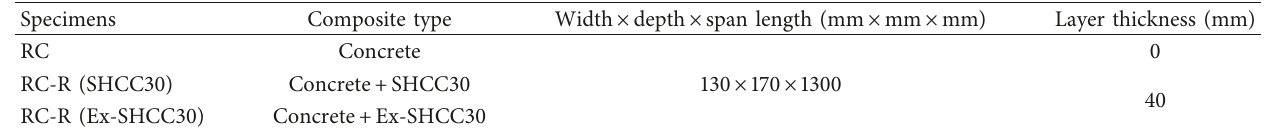
Figure 2: Details of specimen and test setup for structural performance tests. (a) Configuration and reinforcement details (mm). (b) Test setup for four-point bending. Table 4: Summary of reinforced concrete beam